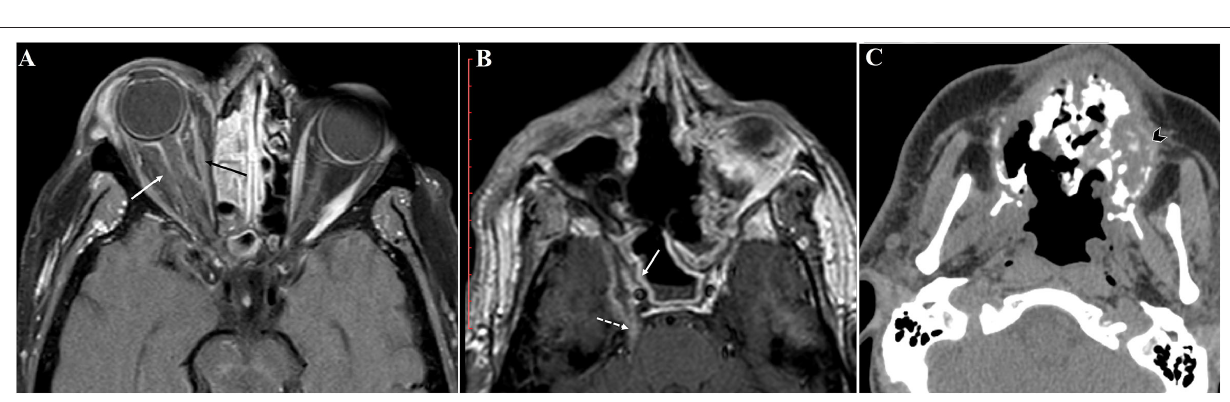
FIGURE 3 | Radiological findings in our rhino-orbital-cerebral mucormycosis (ROCM) cases. Axial postcontrast T1WI showing (A) orbital infiltration with optic nerve sheath inflammatory changes (white arrow), the extra ocular muscles are hypoenhancing (black arrow) secondary to ischemic changes, and (B) cavernous sinus infiltration with lack of expected enhancement (solid white arrow). Perineural spread of the fungus is seen along the trigeminal nerve (dashed white arrow). (C) Axial non-contrast CT reveals destructive sinonasal soft tissue mass with fragmented bone and air loculi secondary to osteonecrosis